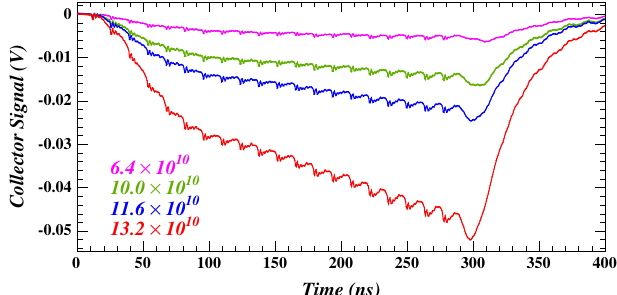
FIG. 4. Dependence of the signals on bunch population for 20-bunch trains with 14 ns spacing. The dependence is strongly nonlinear, the signal amplitude increasing by an order of magnitude for a factor of two increase in bunch population.